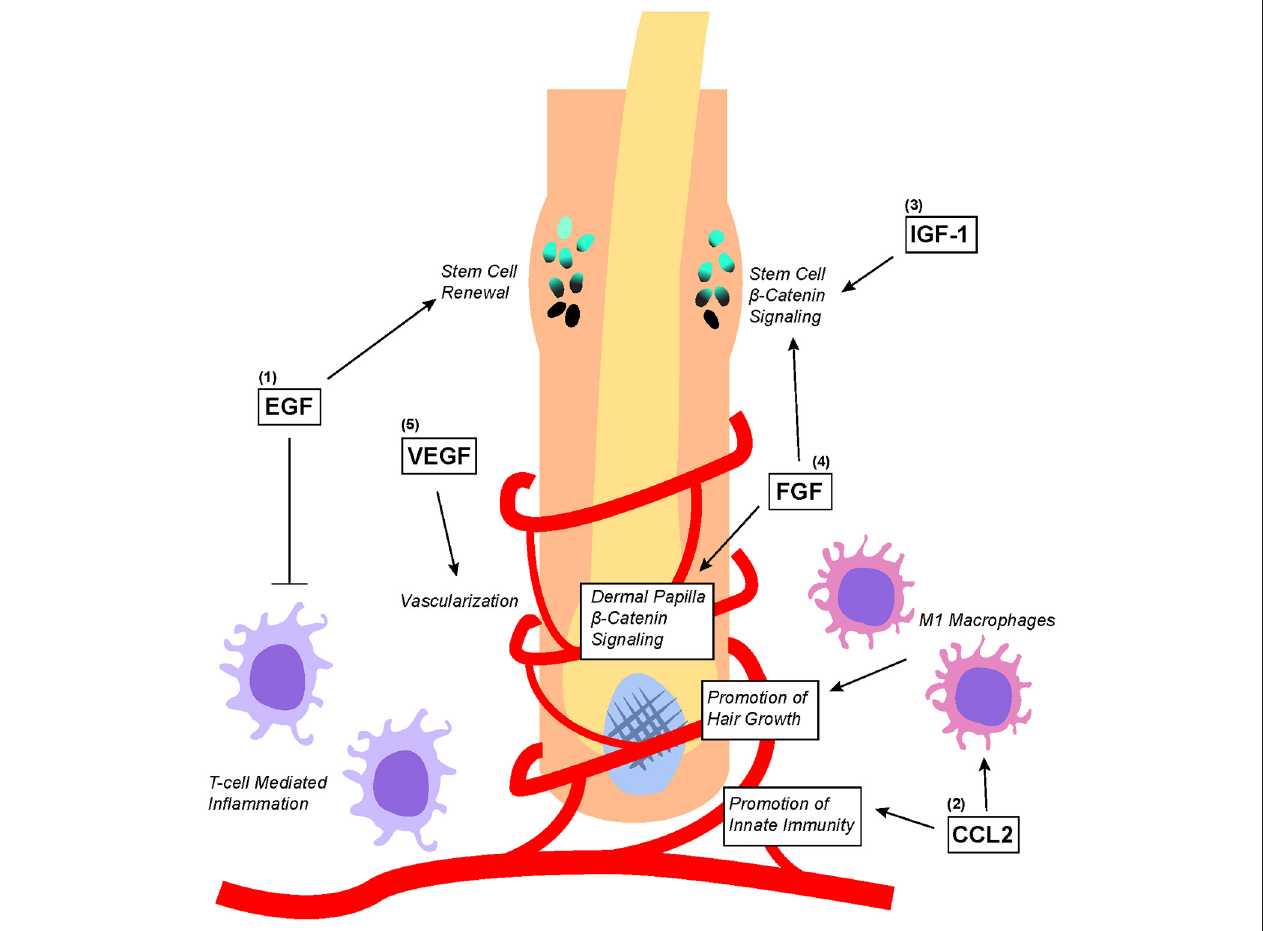
FIGURE 4 | Overview of PRP-associated growth factors and chemokines as well as their effects on hair follicle biology. (1) EGF promotes bulge stem cell renewal by retarding their differentiation; additionally, EGF protects the hair follicle from excessive T-cell mediated inflammation. (2) CCL2 promotes the establishment of hair follicle-specific innate immunity as well as stimulates the recruitment and differentiation of M1 macrophages that promote hair growth. (3) IGF-1 and (4) FGF both directly upregulates Wnt/ β -catenin signaling in the bulge stem cells to promote migration differentiation. Additionally, FGF stimulates Wnt/ β -catenin signaling in dermal papilla to promote hair growth. (5) VEGF stimulates angiogenesis within the hair follicle microenvironment to ensure adequate nutritional delivery.